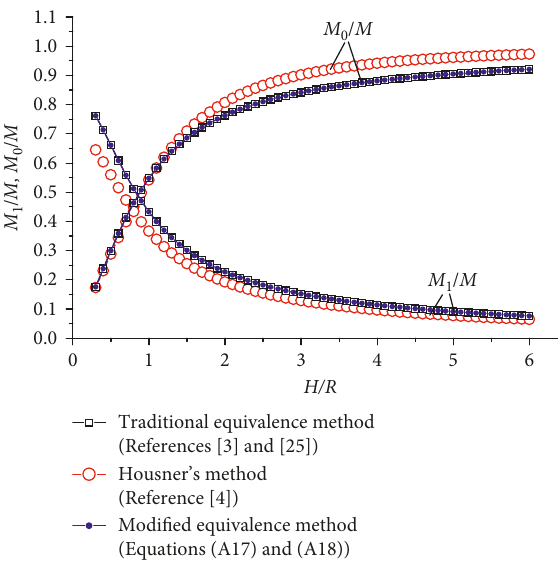
Figure 9: Mass ratios M H / R (cylindrical tank).